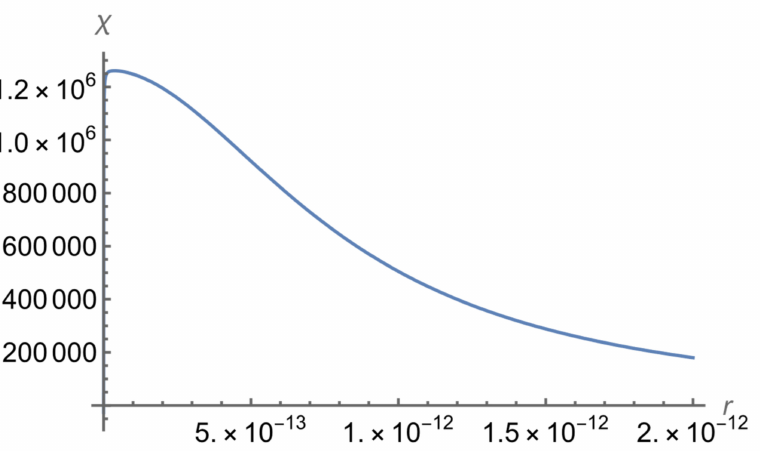
Figure 2. The normalized wave function of the bound E = 0 state of the neutron–muon system for L = 2 at a relatively large